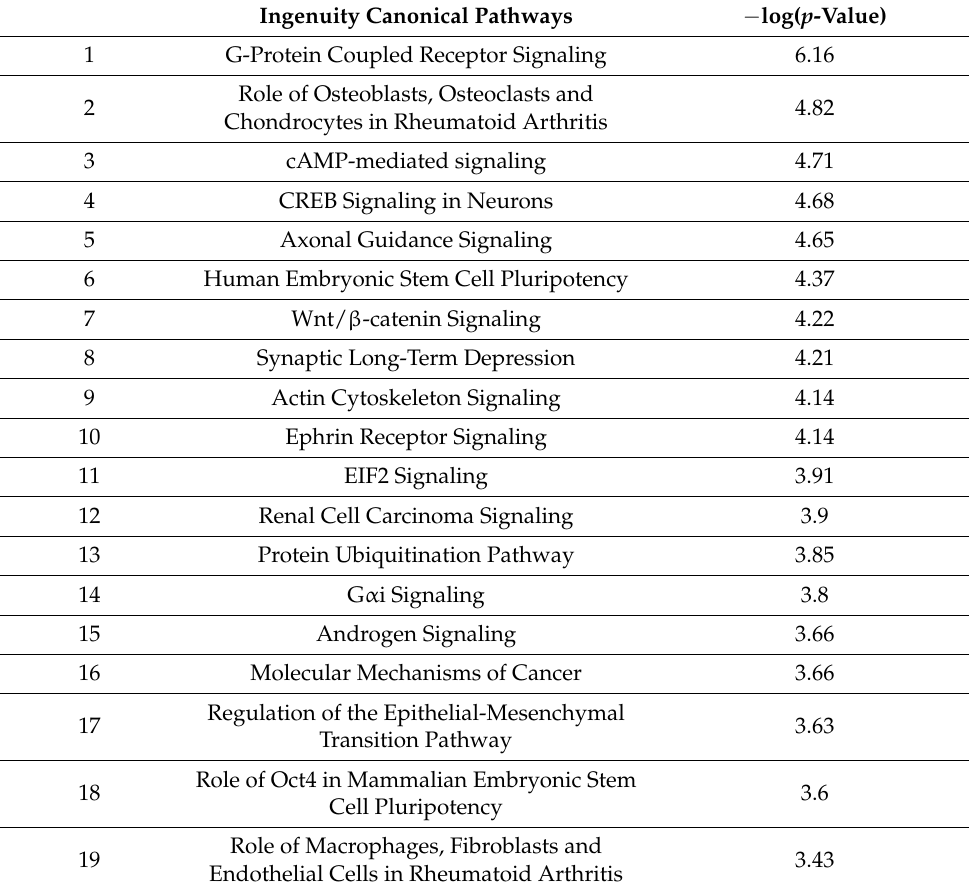
Table 5. The top 25 canonical pathways identified by Ingenuity Pathway Analysis of the